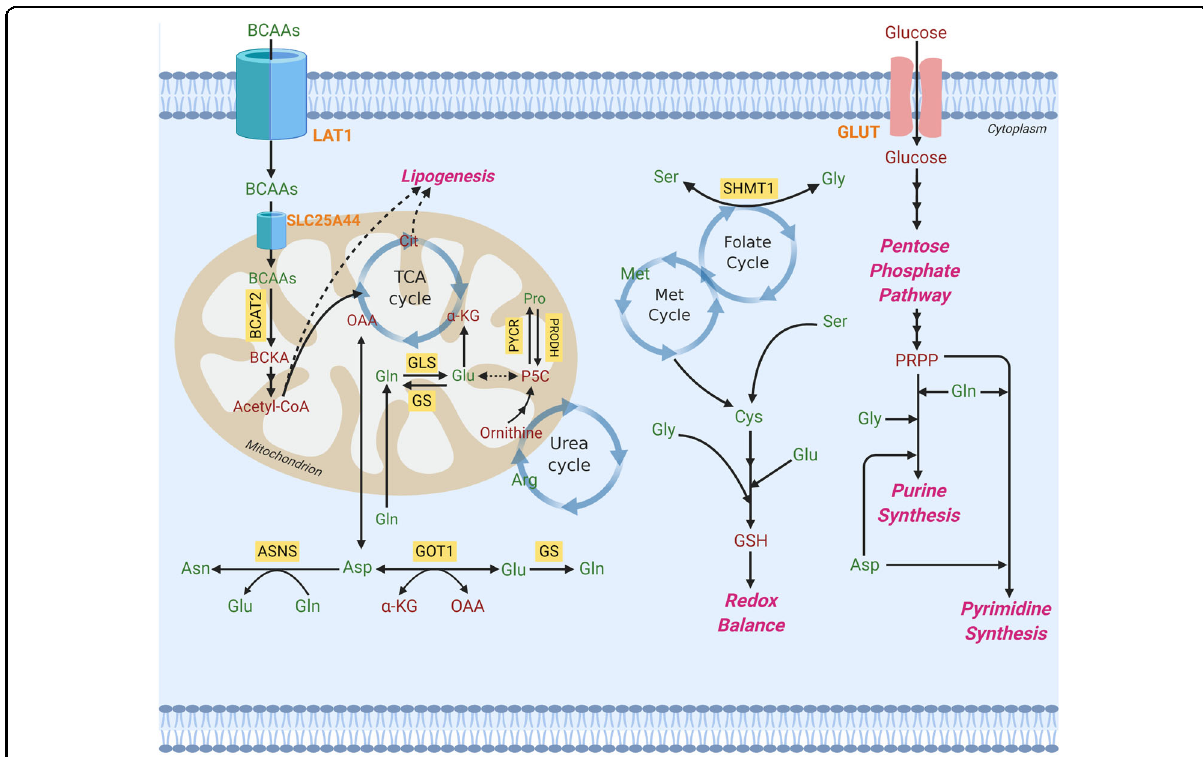
Fig. 1 Amino acids in metabolic pathways. Metabolic reprogramming is a staple of cancer cell growth and proliferation. Both essential and nonessential amino acids (EAAs and NEAAs) support altered metabolism by serving as energy sources, biosynthetic molecules, and mediators of redox balance. Amino acids produce metabolic intermediates, such as acetyl-CoA, that sustain energy synthesis through the citric acid cycle. Amino acids also provide building blocks for nucleotide synthesis and lipogenesis that are critical to a cell ’ s ability to grow and develop. To circumvent the effects of oxidative stress, amino acids can regulate redox balance through their production of glutathione. Furthermore, EAA catabolism contributes to the generation of NEAAs through chemical reactions, including those mediated by transaminases. Amino acids are in green, and other metabolites are in red. Orange represents transporters. Yellow boxes signify enzymes. SHMT1 serine hydroxymethyltransferase, cytosolic, BCAT branched-chain amino acid transaminase, mitochondrial, BCAA branched-chain amino acid (valine, leucine, isoleucine), BCKA branched-chain ketoacid, GOT1 aspartate transaminase, cytosolic (AST), GLS glutaminase, GS glutamine synthetase (cytosolic and mitochondrial), ASNS asparagine synthetase, PRODH pyrroline-5-carboxylate dehydrogenase, PYCR pyrroline-5-carboxylate reductase, P5C pyrroline-5-carboxylate, GSH glutathione, Gly glycine, Ser serine, Met methionine, Met cycle methionine cycle, Gln glutamine, Cys cysteine, Glu glutamate, Asp aspartate, Pro proline, Asn asparagine, Arg arginine, PRPP phosphoribosyl pyrophosphate, acetyl-coA acetyl-coenzyme A, α -KG alpha-ketoglutaric acid, OAA oxaloacetic acid, LAT1 large-neutral